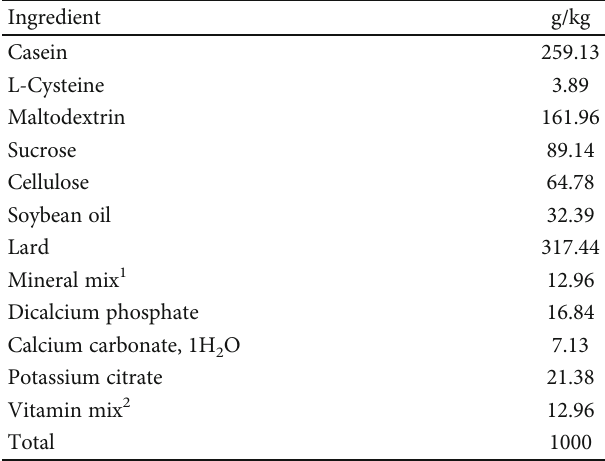
Table 1: Composition of the high-fat